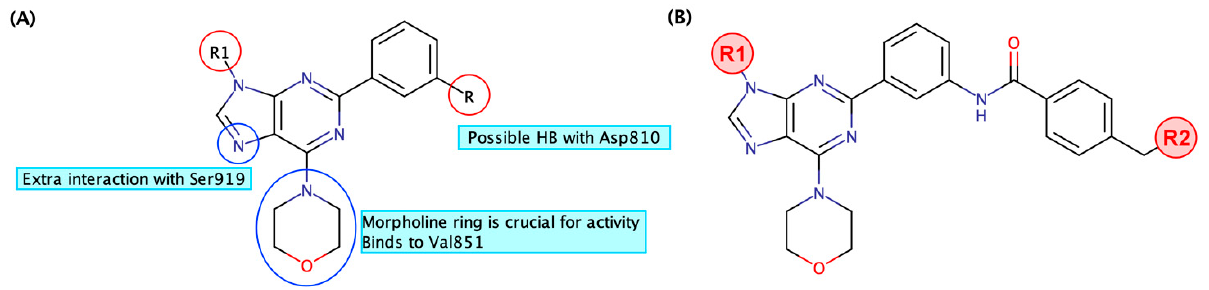
Figure 3 . ( A ) Reported sca ff old of the 2,9-disubstituted-6-morpholino purine derivatives and inter- action-binding pa tt ern with the active site of PI3K α . ( B ) The base structure of the library of com- pounds designed in this